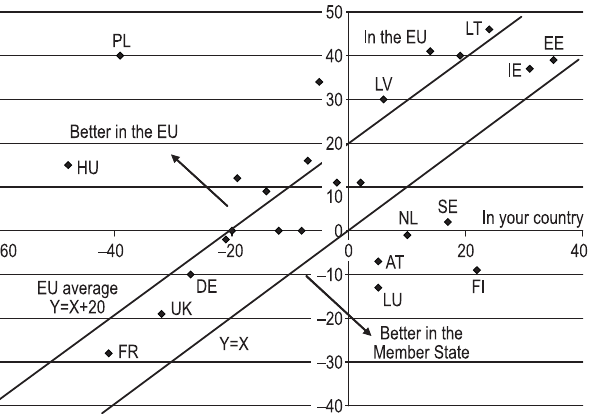
Fig. 16. Are things going in the right